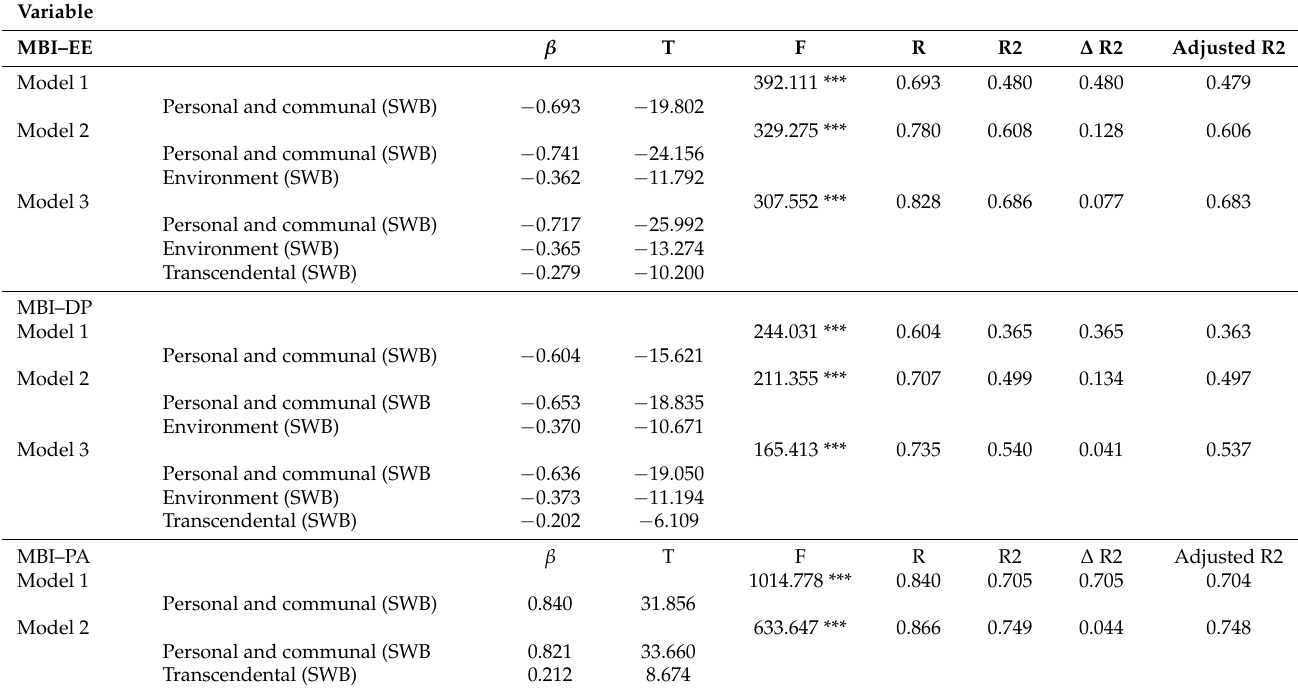
Table 5. Results of hierarchical regression analyses with spiritual well-being (SWB) in the specific domains as predictors of participants’